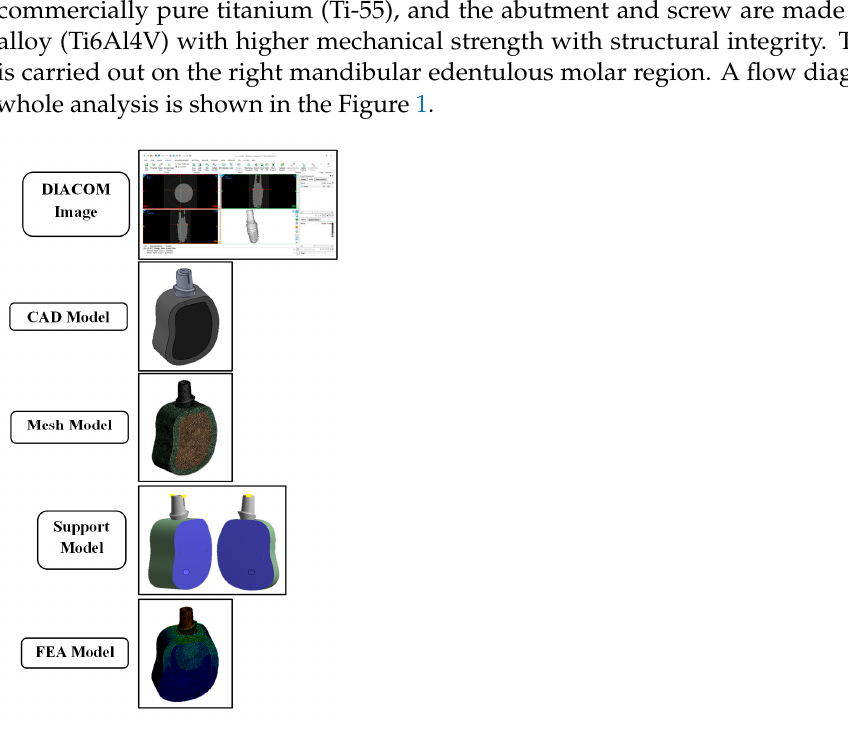
Figure 1. Flow diagram of development of CAD model and FEA analysis: (i) Diacom image data; (ii) CAD model; (iii) mesh model; (iv) support model; and (v) FEA model.